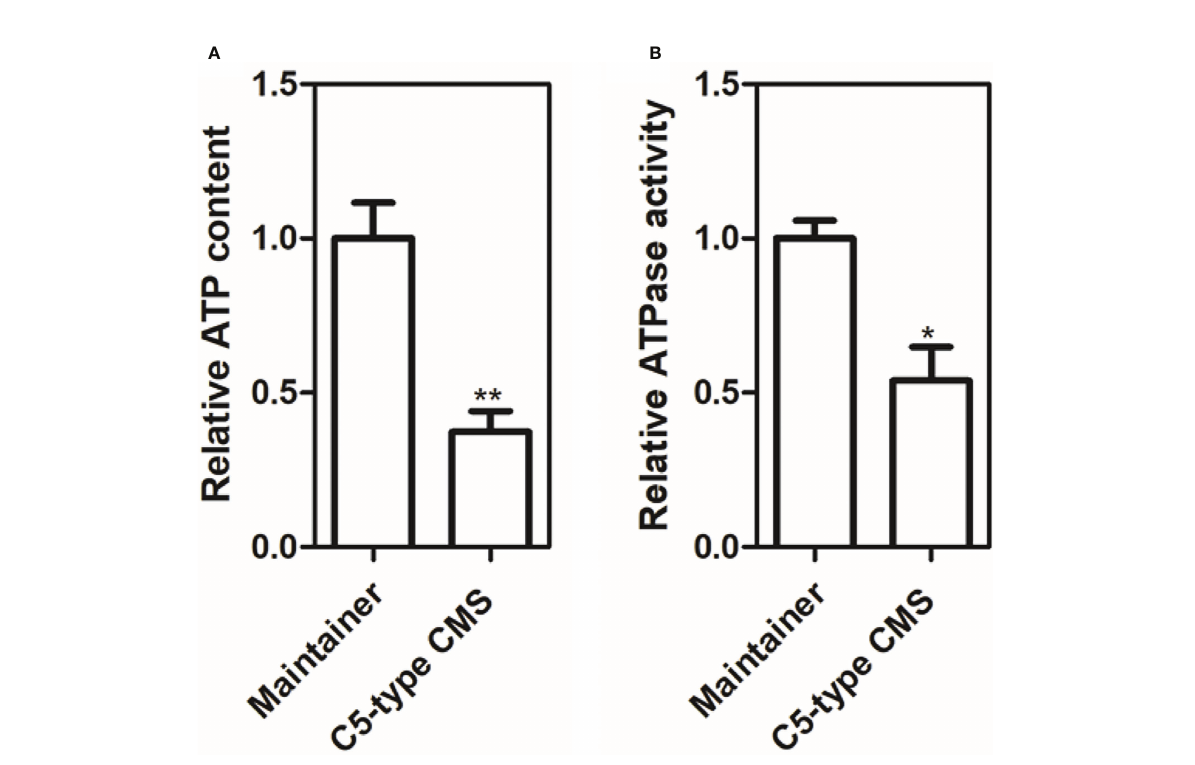
FIGURE 9 Production of ATP and ATP synthase activity in anther samples of maintainer and Ogura-CMS cabbage lines. (A) Comparison of the ATP content in petals of the maintainer and C5-type CMS cabbage lines. (B) Comparison of ATP synthase activity in petals of the maintainer and C5-type CMS cabbage lines. The t test comparison statistics are shown (means ± SDs; n = 3). *P < 0.05; **P <